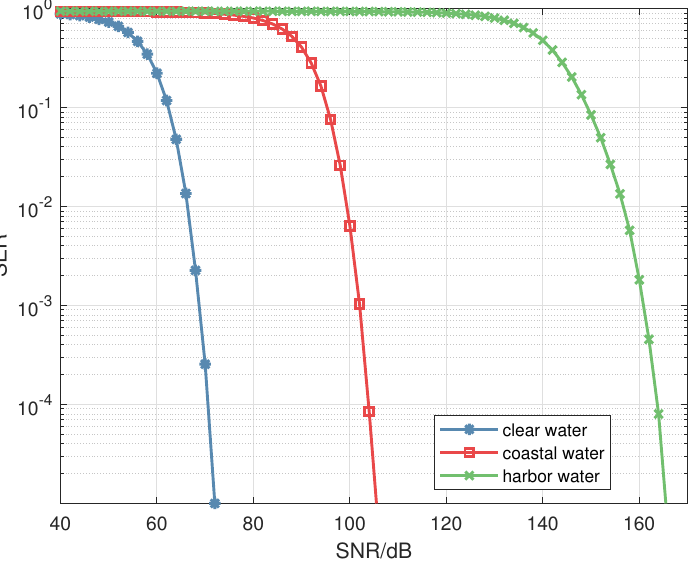
Figure 9. Comparisons with different link distances for the atmospheric channel.